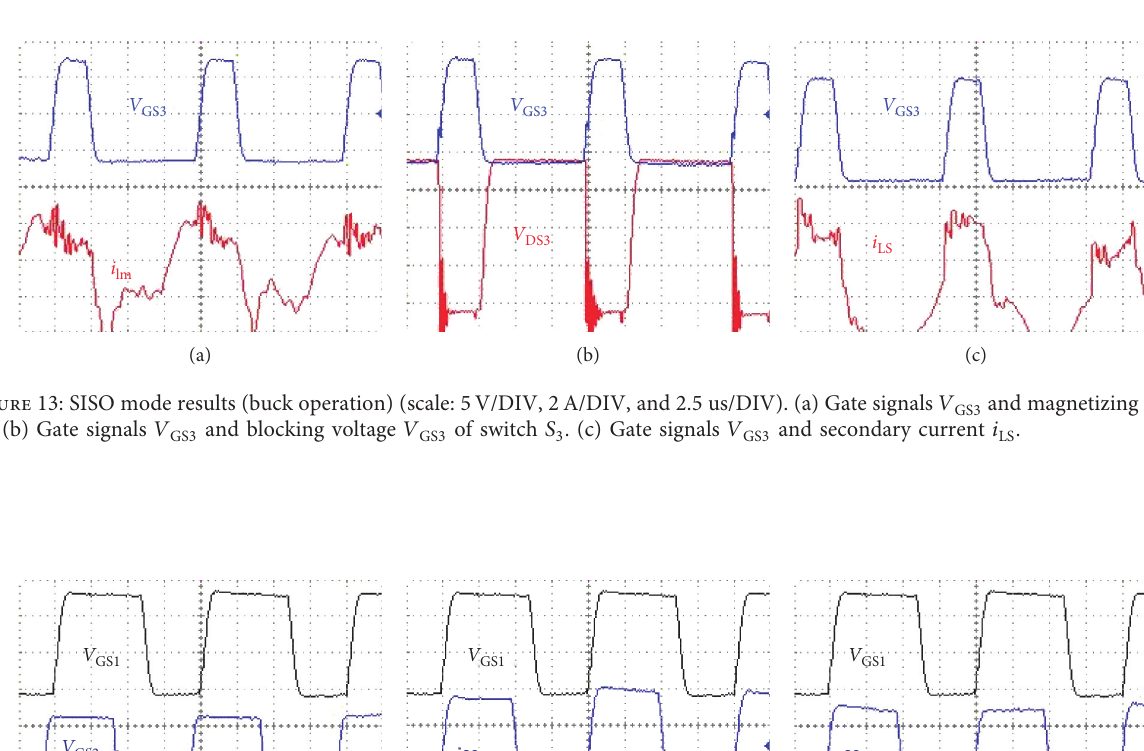
and V during ZVS. DS1 GS1